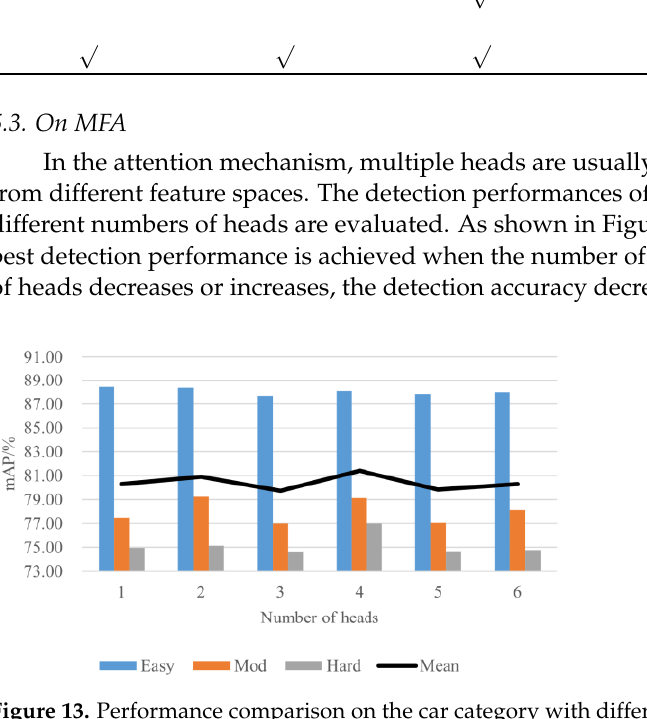
Table 7. The suppression effect of fusion features under rain